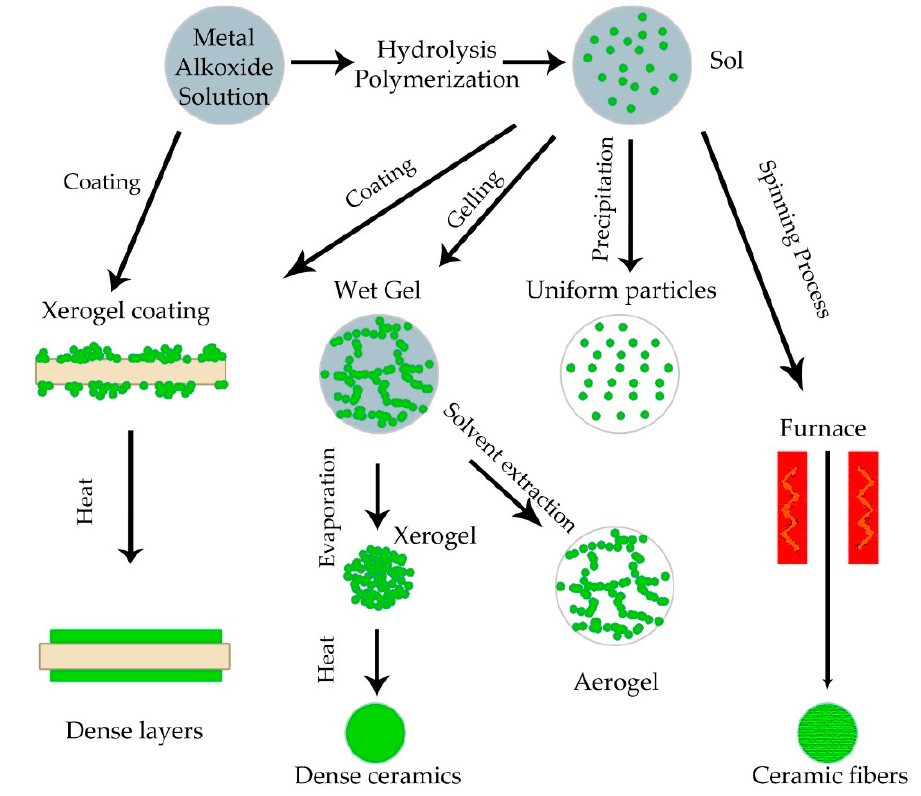
Figure 4. The sol-gel